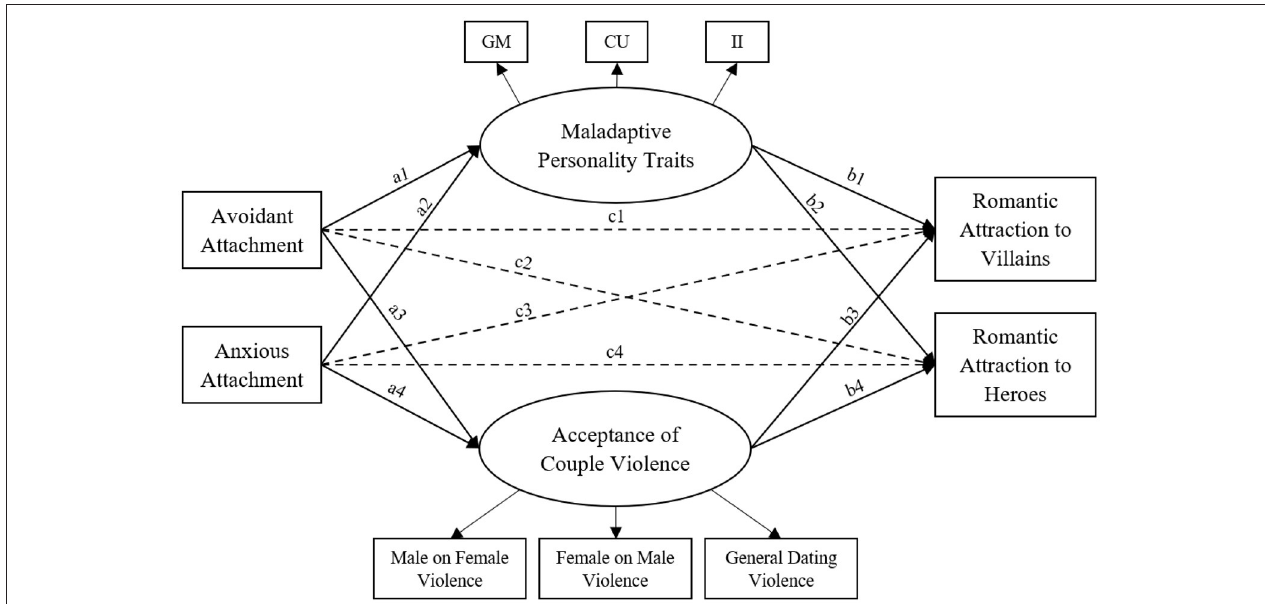
FIGURE 1 | Hypothesized theoretical model predicting romantic attraction to villains and heroes. GM = Grandiose-Manipulative; CU = Callous-Unemotional; II = Impulsive-Irresponsible. Dashed lines represent the direct effects that are expected to be explained by the